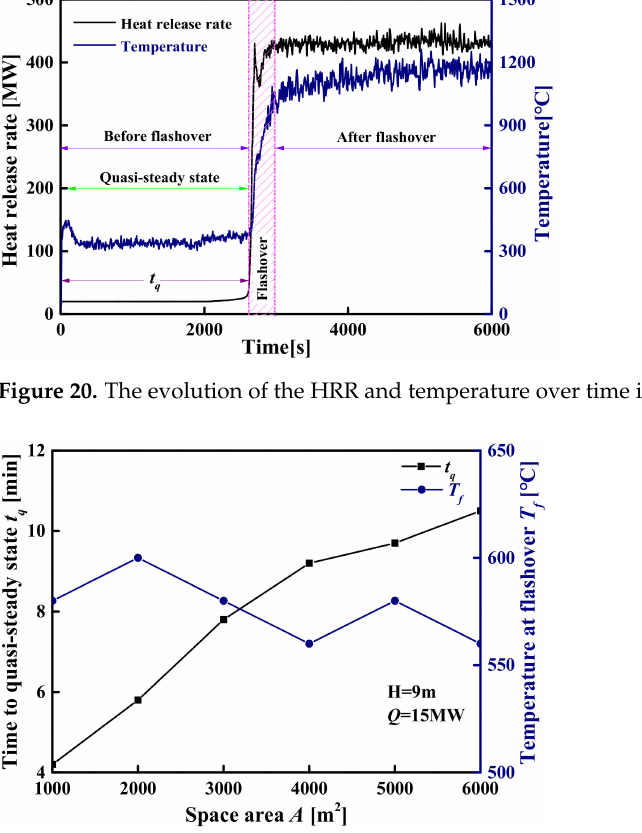
Figure 21. Quasi-steady-state time and flashover temperature in different space areas.